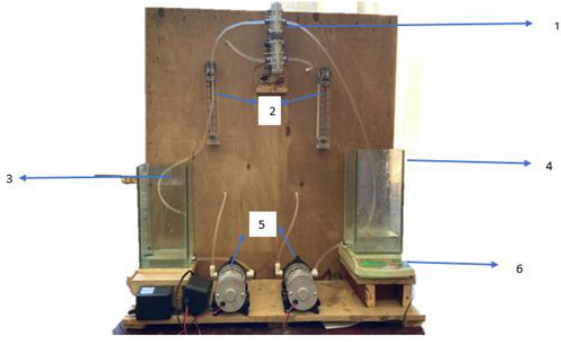
Fig. 1. FO lab unit set up 1) A membrane cell 2) Two flowmeters 3) Feed solution tank 4) Draw solution tank 5) Two Diaphragm pumps 6) Digital balance.